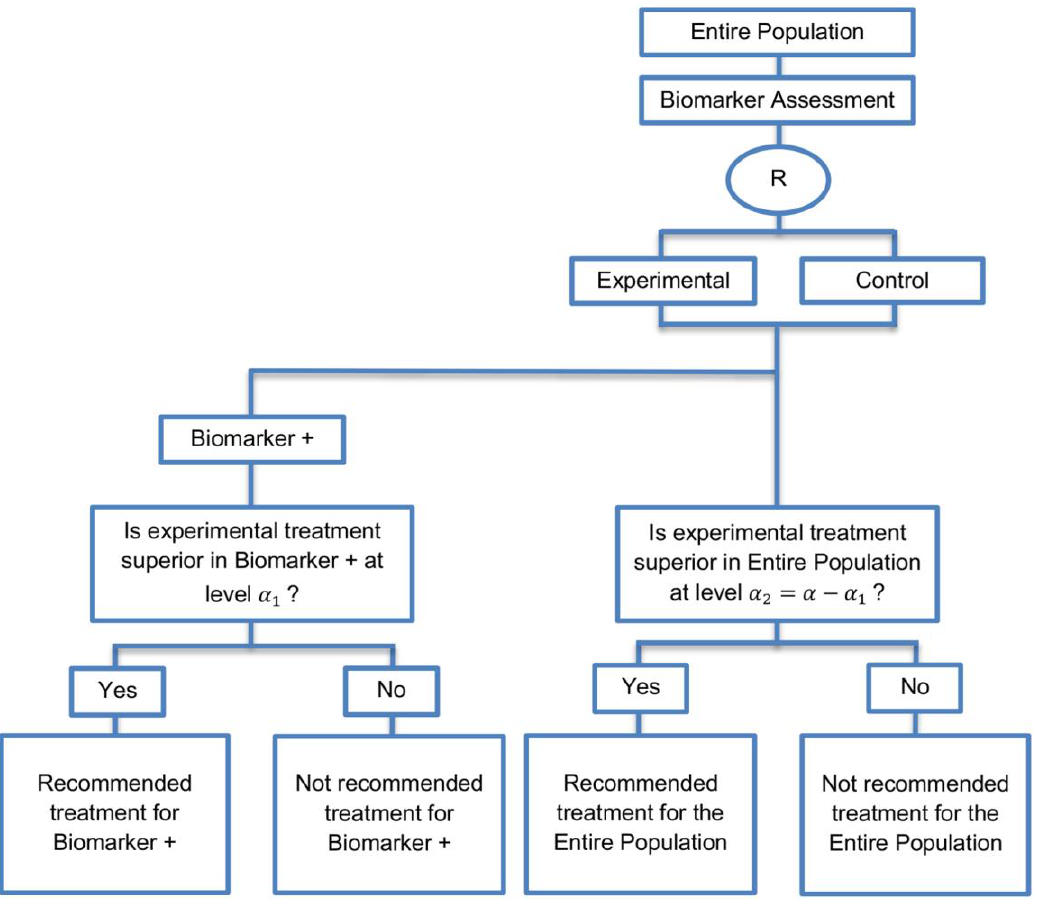
Figure 7. Biomarker-positive and overall strategies with parallel assessment. “R” refers to randomization of patients.